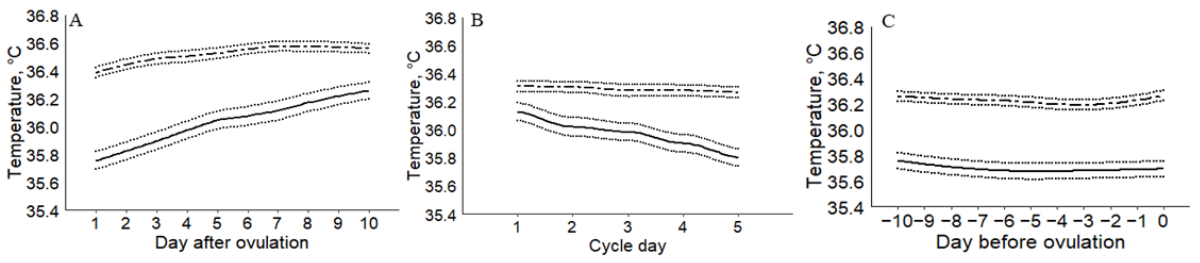
Figure 3. Smoothed temperature curves according to phases. A: postovulatory phase; B: menstrual phase; C: preovulatory phase. Solid and dotted lines represent wrist skin temperature and 95% CIs, respectively; dashed and dotted lines represent basal body temperature and 95% CIs, respectively.